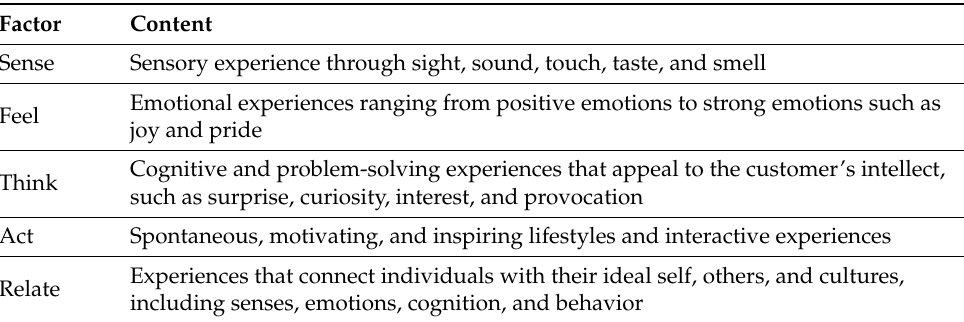
Table 5. Experience